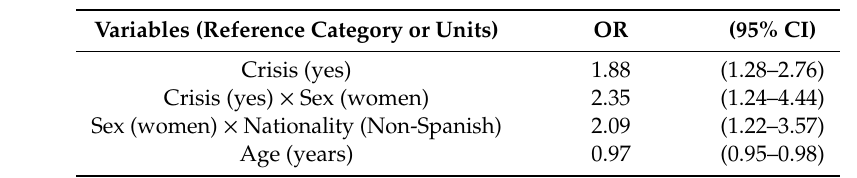
Table 4. Logistic regression for STI diagnosis †